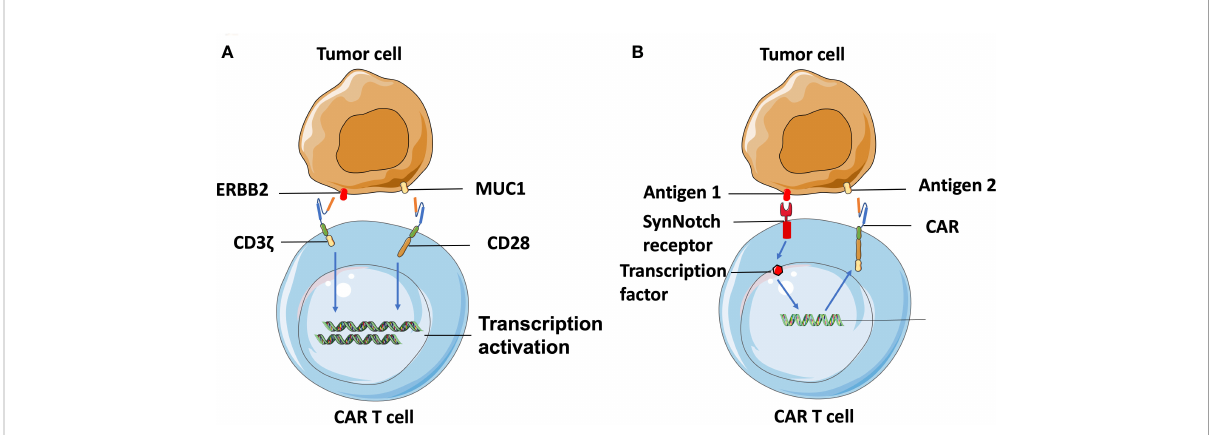
FIGURE 3 Combinatorial-antigen-targeted CAR. (A) ERBB2-targeted CAR signals the CD3 z domain, and MUC1-targeted CAR signals the co-stimulatory CD28 domain. Hence, T cells can only be activated on the engagement of both HER2 and MUC1. (B) Binding of antigens with the extracellular domain of SynNotch receptors induces the proteolysis of the intracellular domain to produce a transcriptional regulator, which is subsequently translocated into the nucleus to regulate transcription of the gene encoding CAR. The CAR molecules are translated following recognition of the second antigen on the tumor cell, which can be the same cell expressing the fi rst antigen or another, different type of